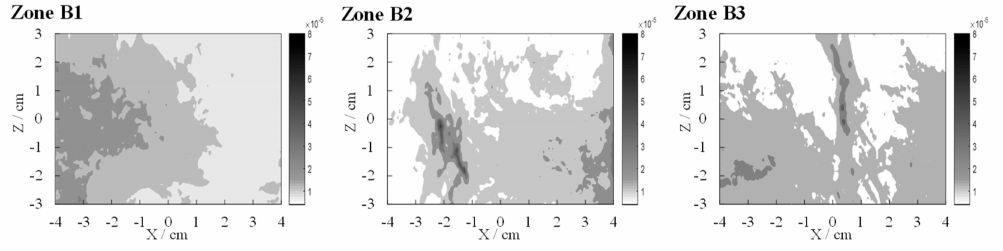
Figure 12. Dissipation rate contours at di ff erent zones when s = 0.5 cm and f = 3 Hz.